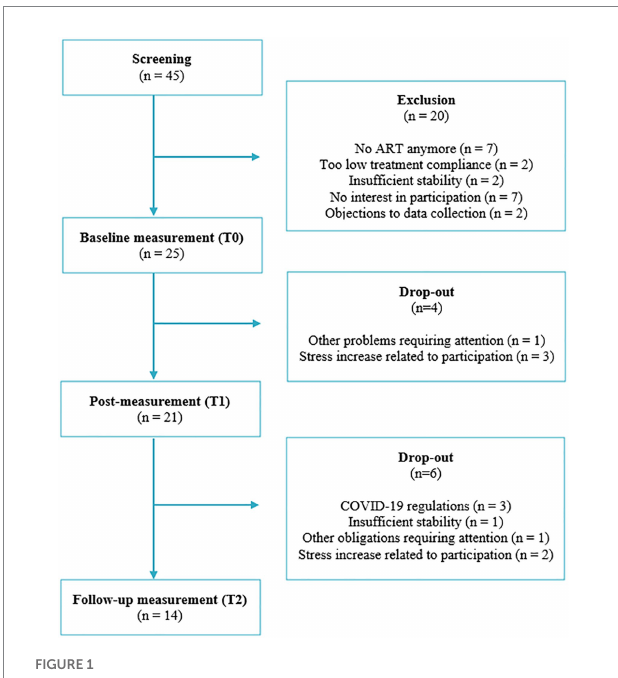
FIGURE 1 Flow chart of recruitment and